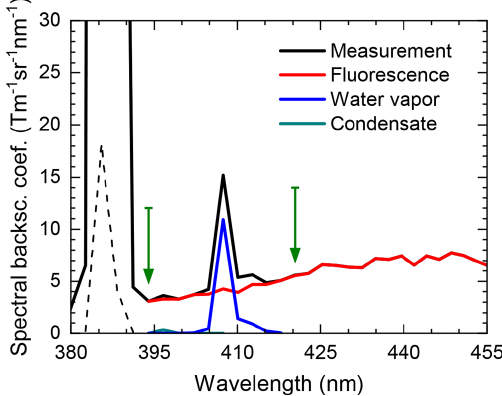
Figure 7. Decomposition of spectra obtained with the UVA spec- trometer as exemplified by the RAMSES measurement at 4.3km on 9 August 2021 at 22:58UTC. Center wavelengths of spectrome- ter detection channels that are unaffected by Raman scattering from molecular nitrogen, water vapor, and condensate (liquid water and ice) are indicated (green arrows). The measurement is multiplied by a factor of 0.03 to fit into the display range around the vibrational– rotational Raman band of N 2 (dashed